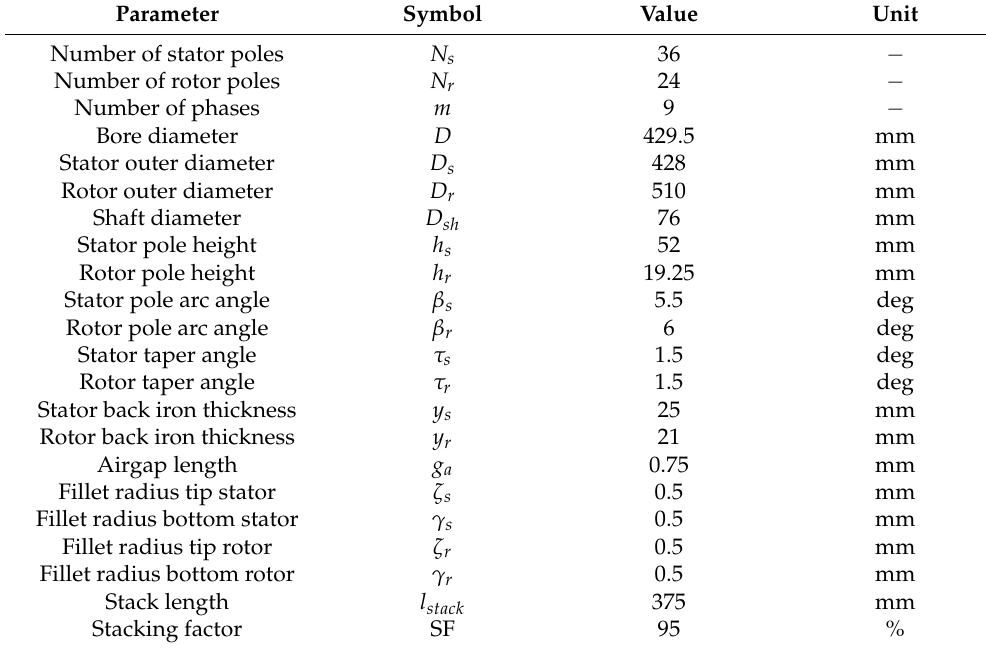
Table 8. Final design parameters of 36/24 ERCV SRM.